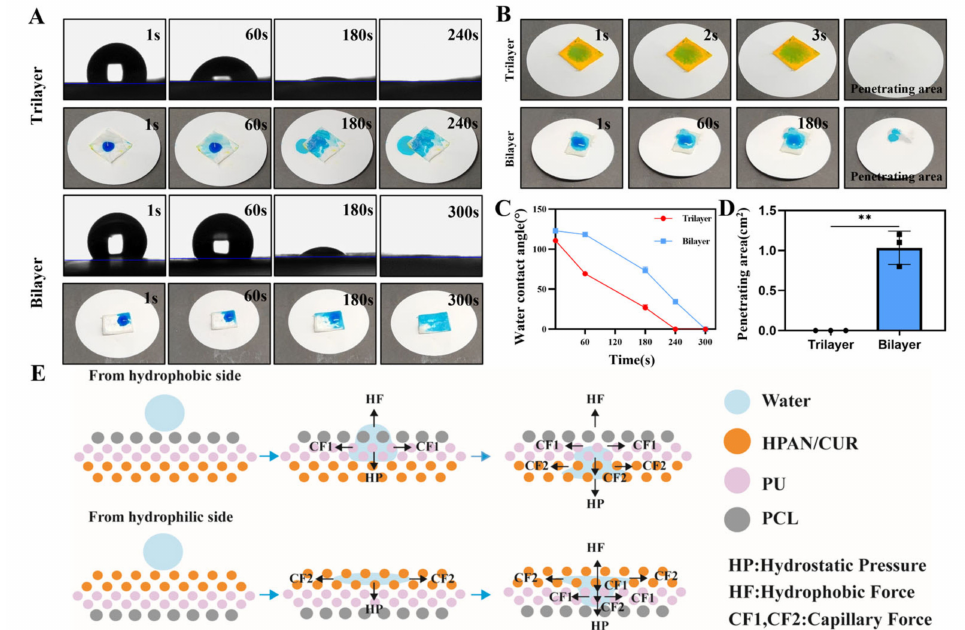
Figure 3. ( A ) Water contact angle (WCA) and images of bilayer and trilayer in hydrophobic side after dropping water. ( B ) Images and the penetrating area of bilayer and trilayer in hydrophilic side after dropping water. ( C ) WCA of bilayer and trilayer. ( D ) Penetrating area in hydrophilic side after dropping water. ( n = 3, mean ± SD, ** p < 0.01) ( E ) The mechanism of the directional water pump form different